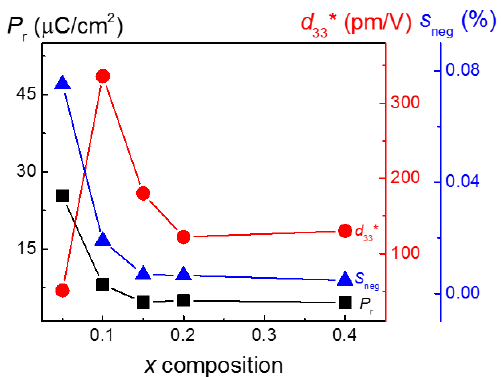
Figure 7. Results for remnant polarization ( P r ), negative strain ( S neg ), and inverse piezoelectric coefficient ( d 33 *) as a function of x represented by black quadrangle, blue triangle, and red circle shapes, respectively.